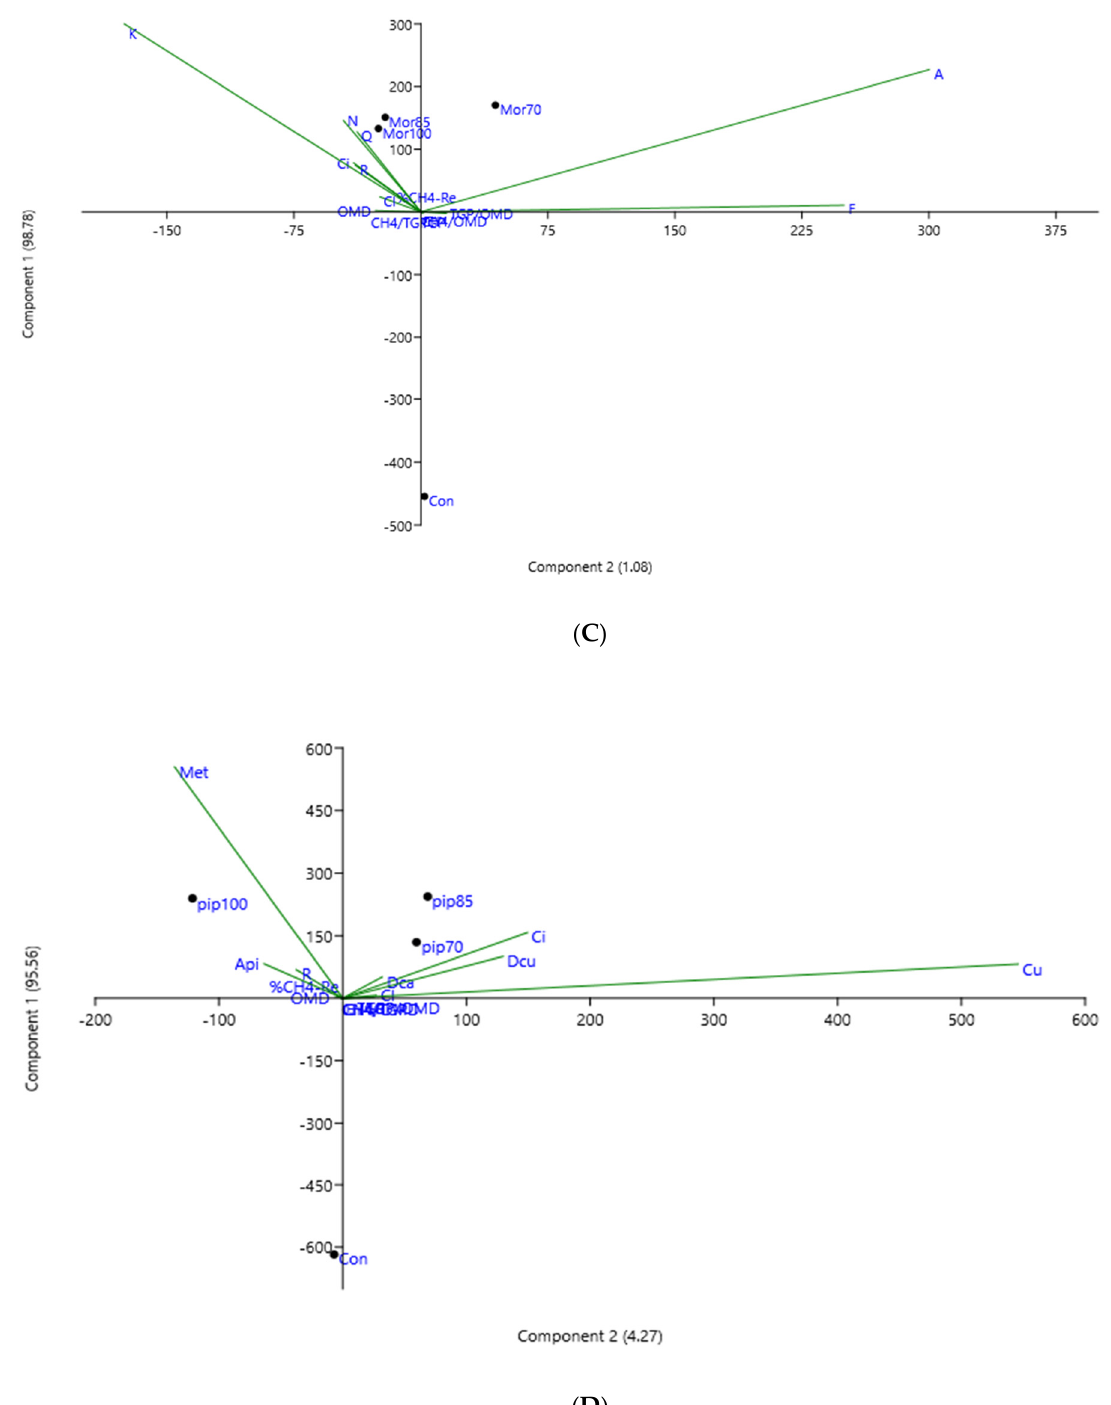
Figure 1. Principal component analysis plot 1 vs. plot 2 of all fermentation parameters of Eragrostis curvula hay fermented with three different aqueous-methanol (70, 85, and 100%) extractions of Aloe vera ( A ), Jatropha curcas ( B ), Moringa oleifera ( C ), and Piper betle ( D ) leaf extracts.